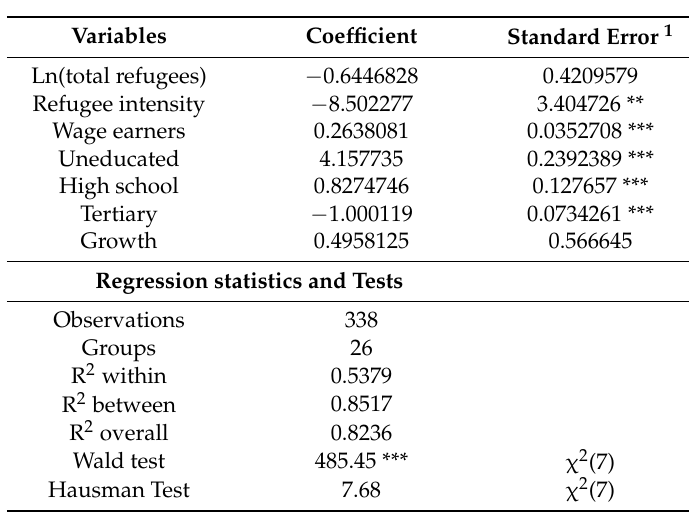
Table 5. Regression results: The determinants of informal